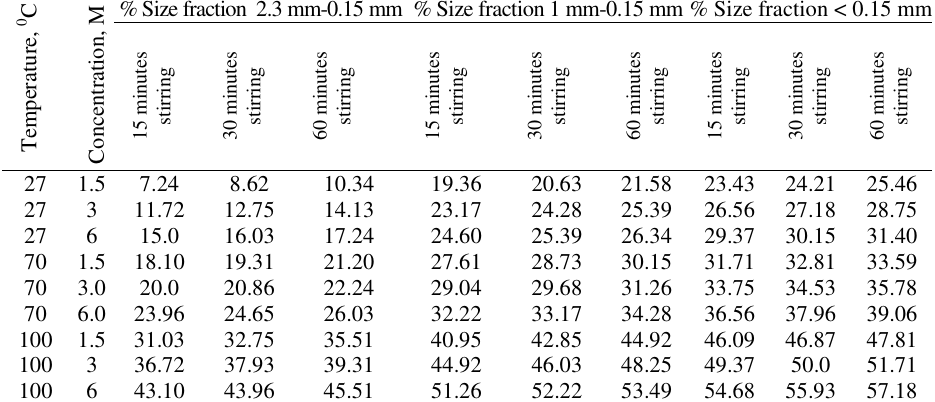
Table 2. Effect of hydrochloric acid on leaching of ash